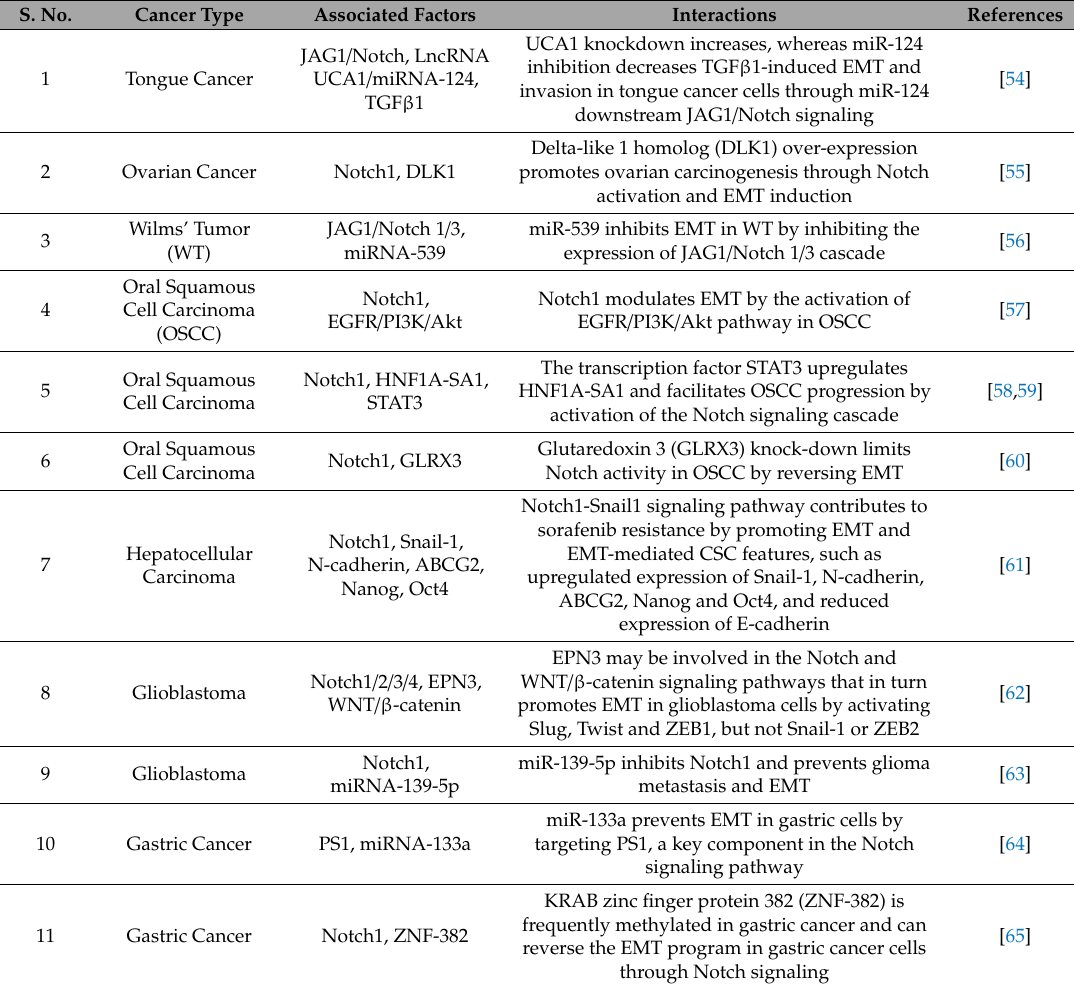
Table 1. Several other Notch based interactions during EMT in cancers other than breast cancer. S.